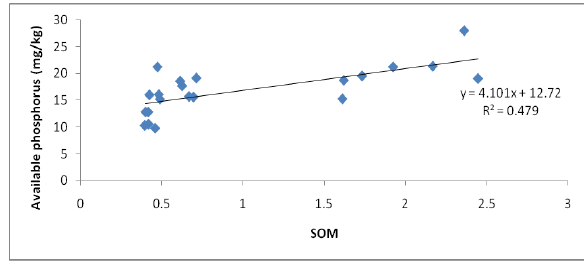
Figure 5: The relationship between SOM content and available